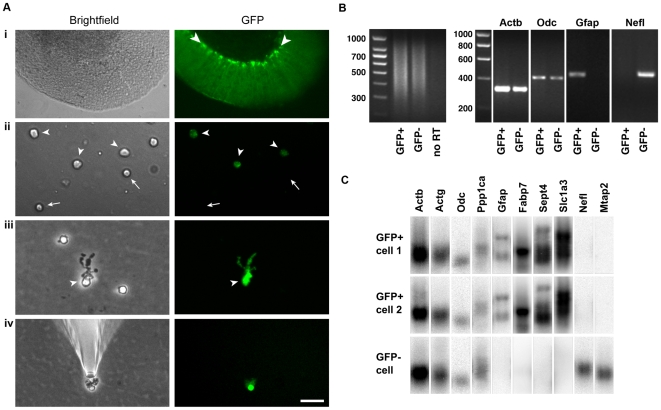
Harvesting of individual Bergmann glia and quality control of single-cell cDNA.
Ai, a live cerebellar slice obtained from an adult GFAP-GFP transgenic mouse imaged under phase contrast optics (left) and fluorescence illumination (right). The Bergmann glia (see arrowheads) are the cells with the most fluorescence. Aii, freshly dissociated cells include putative astrocytes, which are devoid of processes and show relatively weak GFP fluorescence (arrowheads), and putative granule neurons, which have small, round, GFP-negative cell bodies (arrows). Aiii, a freshly dissociated Bergmann glia (arrowhead in left panel) can be distinguished from other cells by the bushy processes that emanate from one side of the soma–these are the long Bergmann glial processes that have partially retracted or been sheared off during tissue dissociation. In addition, Bergmann glia display strong GFP fluorescence (arrowhead in right panel), with the mean GFP intensity of their cell bodies 2.9±0.8 fold that of astrocytes; n = 17 cells). Aiv, a single Bergmann glia being washed by placement in a new dish containing fresh buffer, before being picked again with a new microelectrode. This step is performed to exclude contaminating cells or mRNAs. Scale bar, 70 µm in Ai, 25 µm in Aii and Aiii, 40 µm in Aiv. B, left panel, agarose gel electrophoresis of cDNAs generated from single GFP+ and GFP− cells. The gels show that most of the cDNA lies between 300 and 1000 bases. Right panel, agarose gels showing PCR with primer pairs directed towards β-actin (Actb), ornithine decarboxylase (Odc), Gfap, and neurofilament light chain (Nefl). The results show that the single cell cDNAs from Bergmann glia (GFP+) and neurons (GFP−) contain both high and low abundance transcripts (Actb and Odc, respectively). Bergmann glia are positive for the astroglial marker Gfap and negative for the neuronal marker Nefl, whereas neurons are negative for Gfap and positive for Nefl. C. Southern blot analysis of cDNAs from two putative Bergmann glial cells (GFP+) and a putative neuron (GFP−) shows presence of the high, medium, and two low abundance markers (Actb, Actg, and Odc and Ppp1ca, respectively). In addition, the GFP+ cells are positive for Gfap, Fabp7 (BLBP), Sept4 and Slc1a3 (GLAST), confirming their glial identity, whereas the GFP− cell lacks all these markers. Conversely, the GFP+ cells are absent for the neuronal markers Nefl and Mtap2 whereas the GFP− cell is positive. These results confirm the preservation of low to high abundance transcripts after the single-cell RT-PCR amplification, and also confirm the cell identity of the Bergmann glia used for microarray analysis.